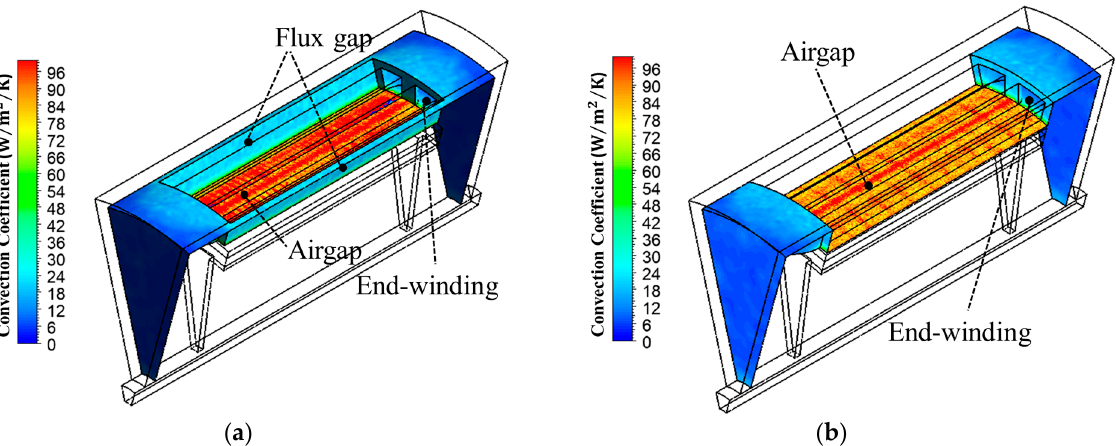
Figure 8. Convection coefficient distribution on different surfaces inside ( a ) a modular machine and ( b ) a non-modular machine. The rotor speed is 1500 rpm.